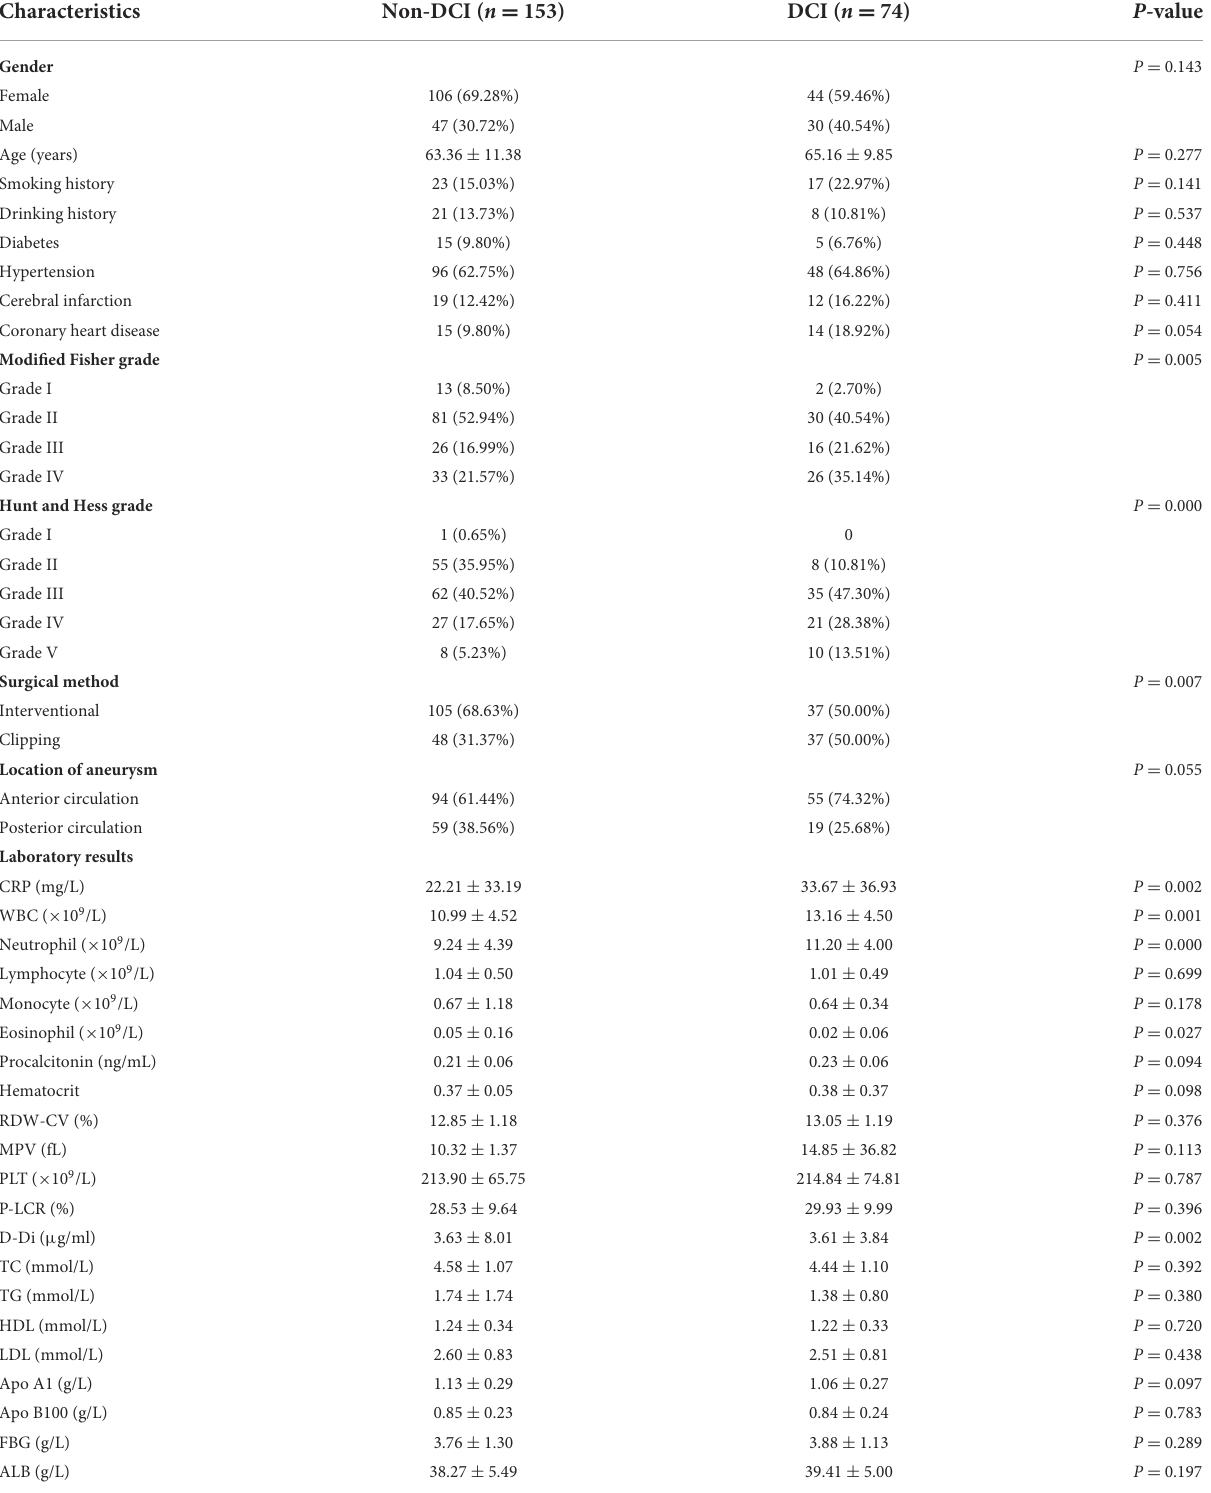
TABLE 1 Univariate analysis (Based on DCI group, non-DCI